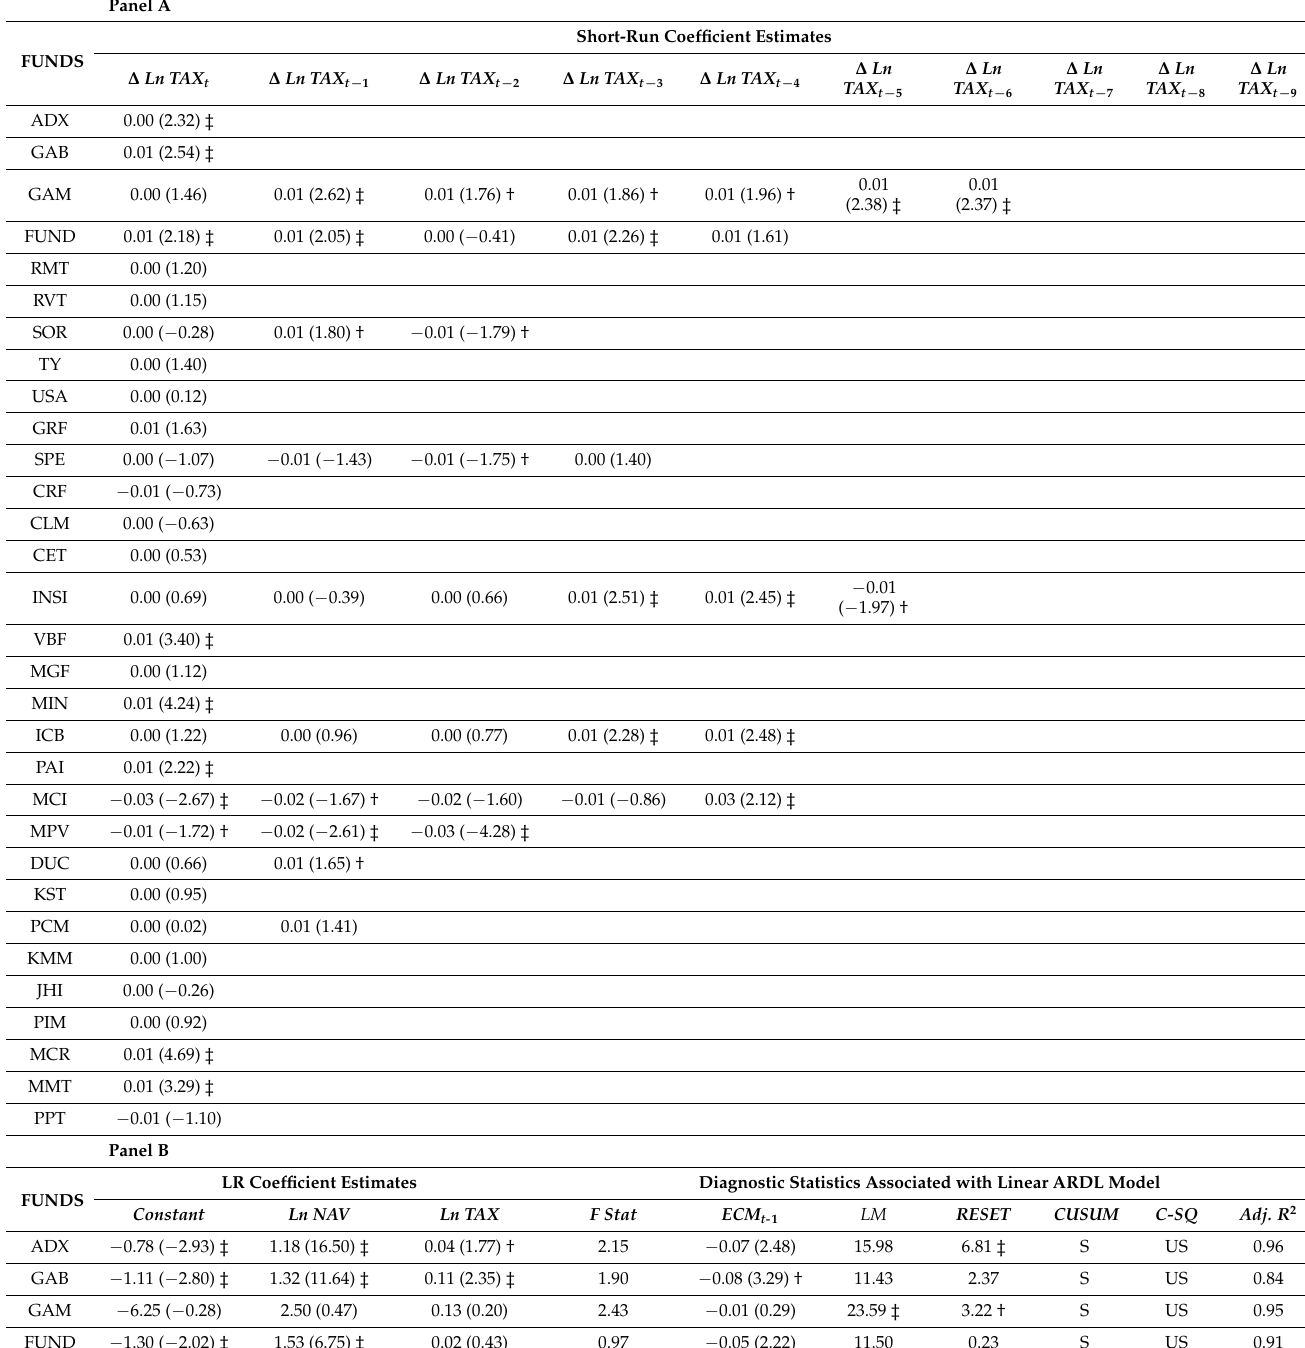
Table 4. Short-Run Coefficient Estimates—Linear ARDL—Model P = f (NAV,